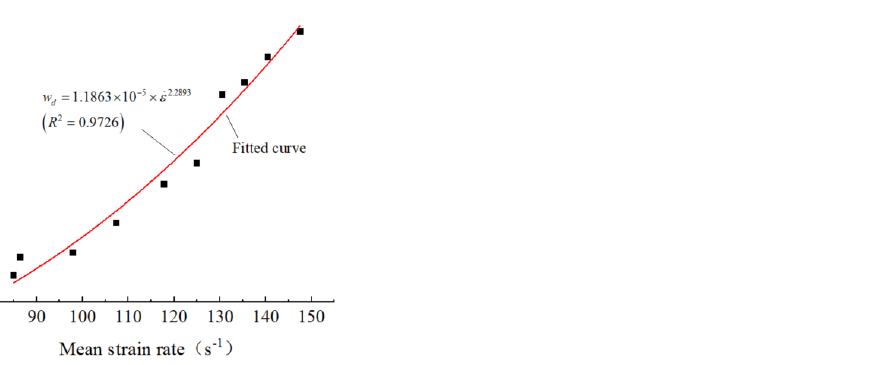
Figure 12. Relationship between crushing energy dissipation density and average strain rate of phyllite samples.